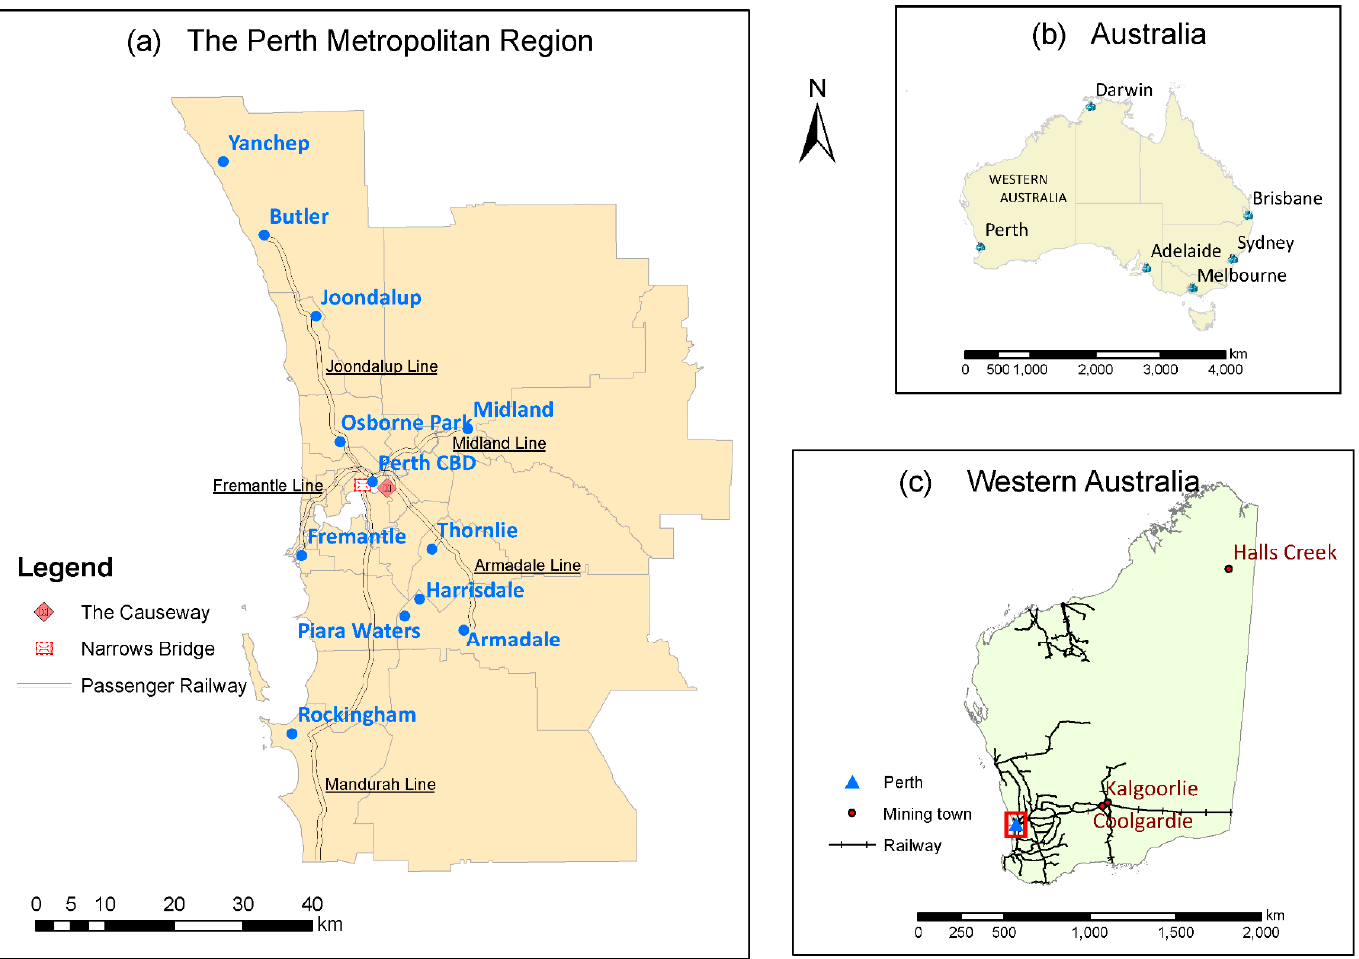
Figure 1. (a) The Perth Metropolitan Region. (b) Geographic location of Australia’s major cities. (c) Locations of key mining towns in Western Australia. Source: Made by 2 Figure 1. ( a ) The Perth Metropolitan Region. ( b ) Geographic location of Australia’s major cities. ( c ) Locations of key mining towns in Western Australia. Source: Made by